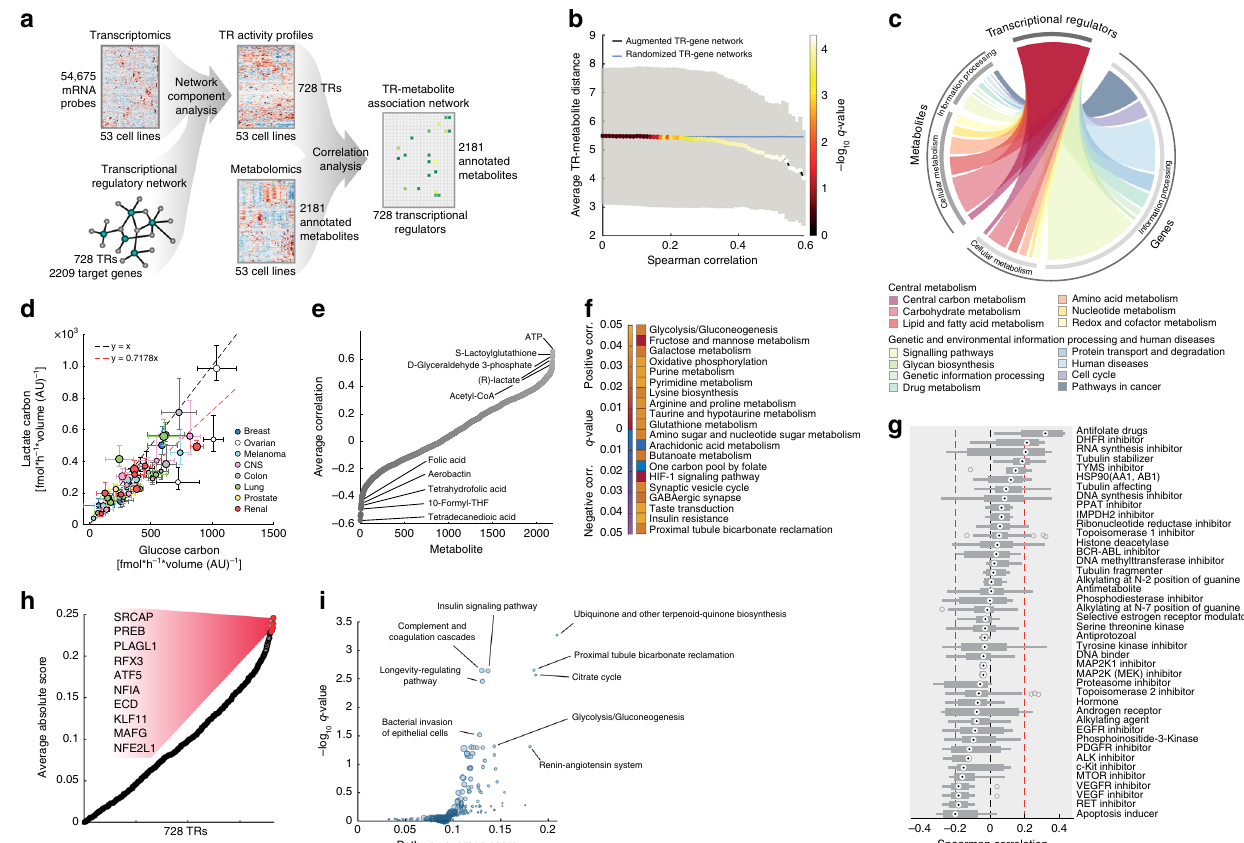
Fig. 2 Inferring a TR-metabolite association network by integrating transcriptome and metabolome data. a Schematic overview of the computational framework for fi nding TR-metabolite associations. Activity of 728 human TRs was calculated using Network Component Analysis 29 on expression pro fi les of the NCI-60 cell lines 10 and the TRRUST transcriptional regulatory network 24 . Correlation analysis was used to fi nd associations between TRs and metabolites. b Correlations between metabolite levels and TR activity pro fi les in relation to the distance between TRs and enzyme targets in the metabolic network 21 . The black line represents average TR-metabolite distance ( y -axis) at different levels of absolute TR-metabolite correlation ( x -axis). The blue line represents average TR-metabolite distance in 10.000 randomized networks. Dot color indicates signi fi cance ( q -value, corrected for multiple tests) of TR- metabolite proximity compared to the randomized networks. c Distribution of TR-metabolite associations (0.1% FDR, left section) and TR-gene regulatory interactions (right section) across KEGG pathways. Edge-size connecting the TR hub and metabolic pathways re fl ects the number of links found in either network. d Glucose uptake vs lactate secretion. Mean ± standard deviation of rates estimated over three biological replicates and fi ve time points. e , f Metabolites whose abundance correlated with glycolytic fl ux (i.e., glucose uptake and lactate secretion, e ) were tested for signi fi cant ( q -value, corrected for multiple tests) enrichment in KEGG metabolic pathways ( f ), separately for positively and negatively correlated metabolites (yellow to red and purple to blue color ranges, respectively). g Boxplot of the correlation between glucose uptake/lactate secretion and sensitivity (i.e., GI 50 , drug concentration causing 50% growth rate reduction) to 430 drugs 31 grouped by mechanism of action. Box edges re fl ect 25th and 75th percentiles, center dots indicate medians, whiskers include extreme data points, and outliers are gray circles. h Association between TR activity and metabolites reporting on glycolytic fl ux. TR names are shown for the 10 TRs with the highest score. i For each KEGG pathway we calculated the average association score ( h ) among TRs with known enzyme targets in the pathway ( x -axis). Signi fi cance ( y -axis) is estimated using a permutation test and corrected for multiple tests ( q -value). Only pathways with a q -value ≤ 0.01 are